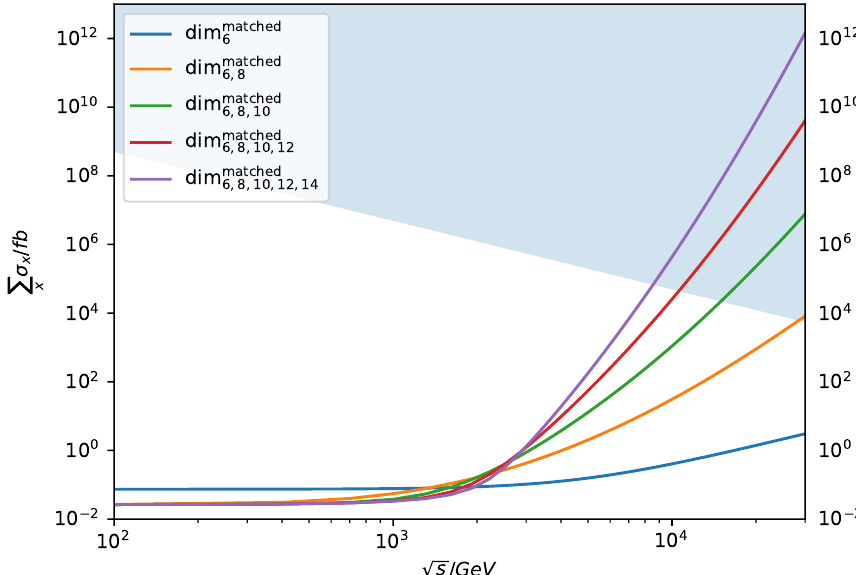
Figure 3 . Inclusive inelastic cross section µ + µ − → X for multiple Goldstone and Higgs-boson production in the GBET approximation. We show the result for the sequence of SMEFT scenarios defined by the conditions (2.25), truncated at dimension d = 6 , 8 , 10 , 12 , 14 , respectively. The maximal multiplicity of the final state is n = 3 , 5 , 7 , 9 , 11 , respectively. The shaded area indicates the region that is excluded by the universal unitarity bound for the inclusive cross section